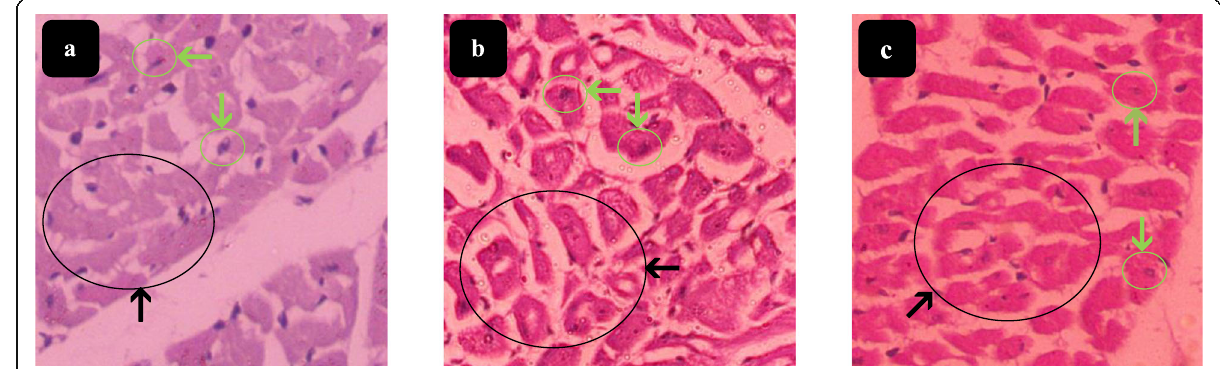
Fig. 3 Cardiac histology GE (200 mg/kg-bw/day) treated rat (Group 3): ( a ) sacrificed on 31st day revealed intact undamaged myofibrils (pointed with black arrow) and normal distribution of nuclei (pointed with green arrow), ( b ) sacrificed on 46th day depicted more pronounced normal and undamaged myofibrils (pointed with black arrow) and regular centered distribution of nuclei (pointed with green arrow), ( c ) sacrificed on 61st day exhibited the most evident normal cardioarchitecture with intact myofibrils without inflammation (pointed with black arrow) and disaggregated central distribution of nuclei (pointed with green